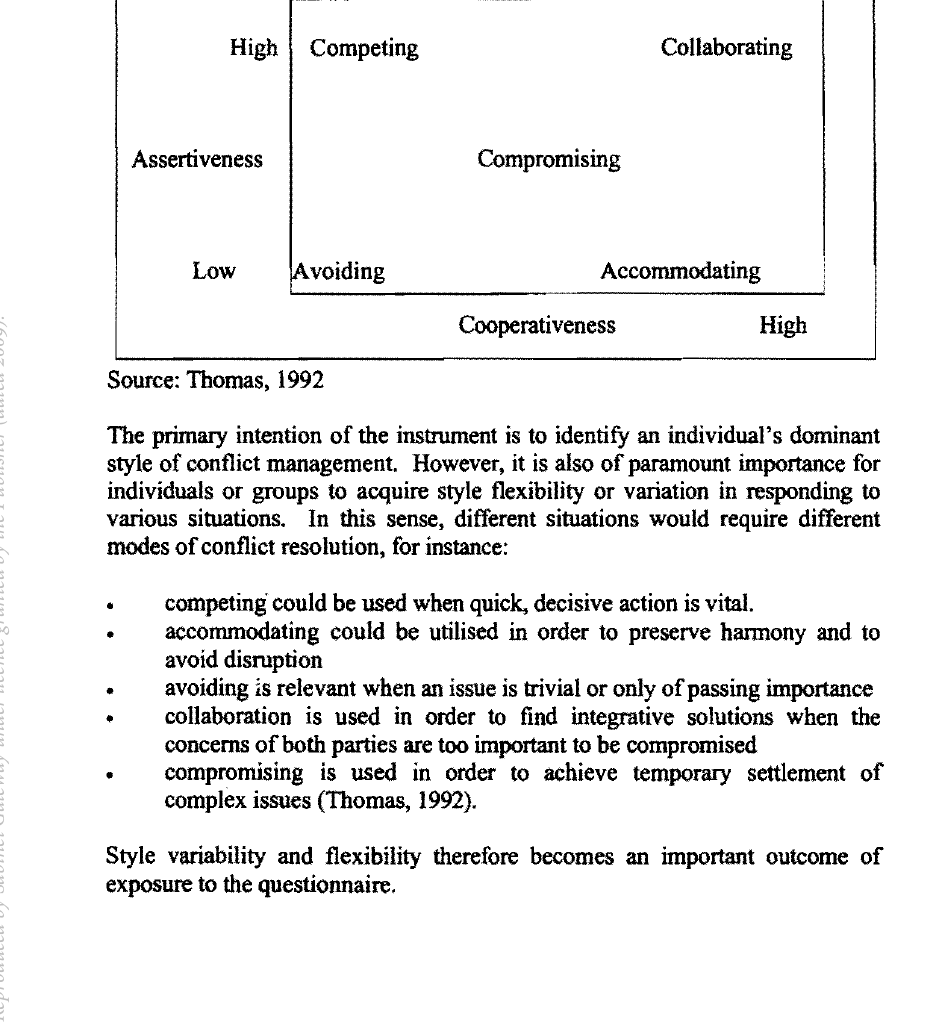
High Competing Collaborating